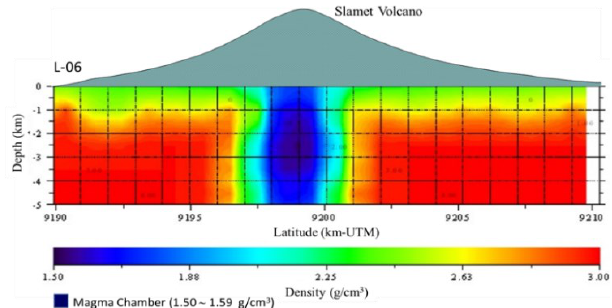
Fig. 10. A cross-section of the anomalous object model along L-01 trajectory at latitude of 9,197.520 km-UTM